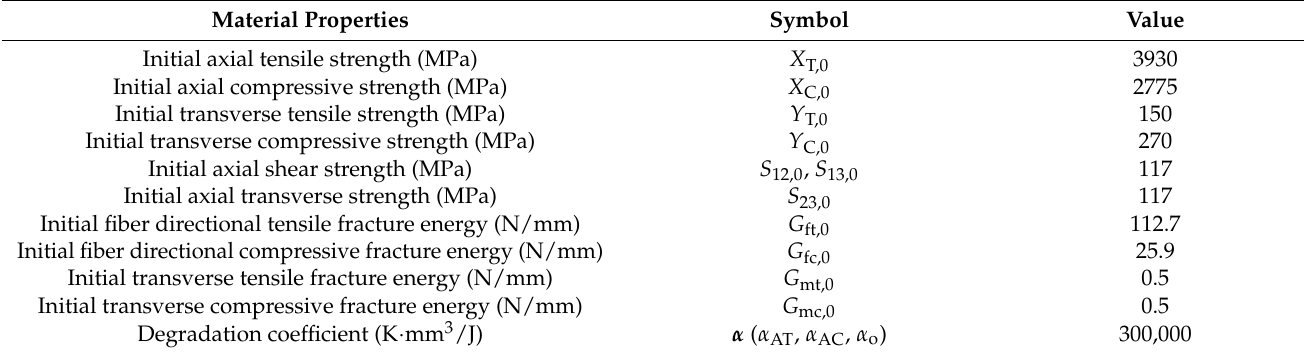
Table 2. Strength and degradation properties of CFRP laminate